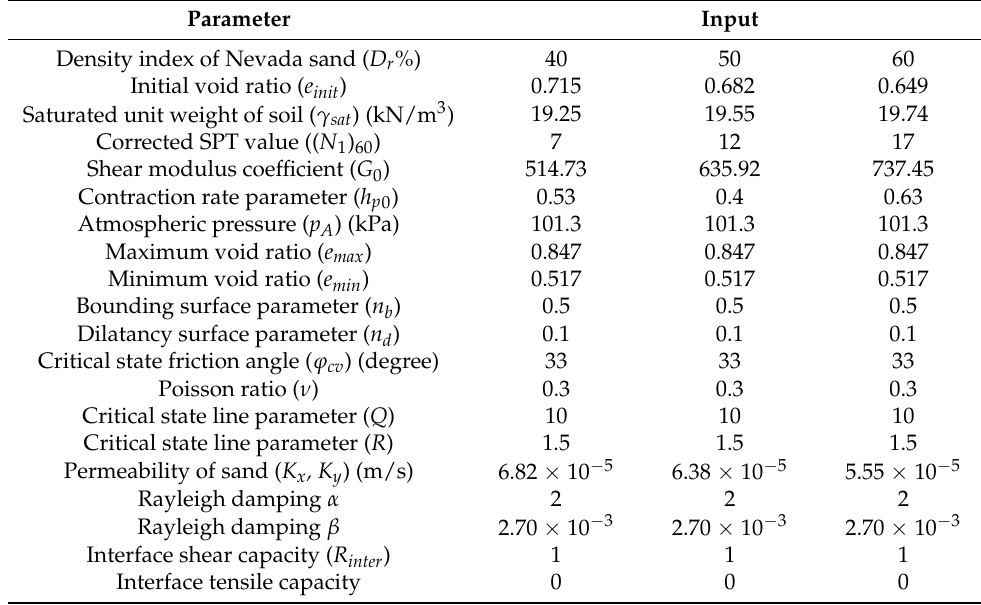
Table 2. Properties of the soil incorporated in the PM4Sand model for the dynamic analysis.